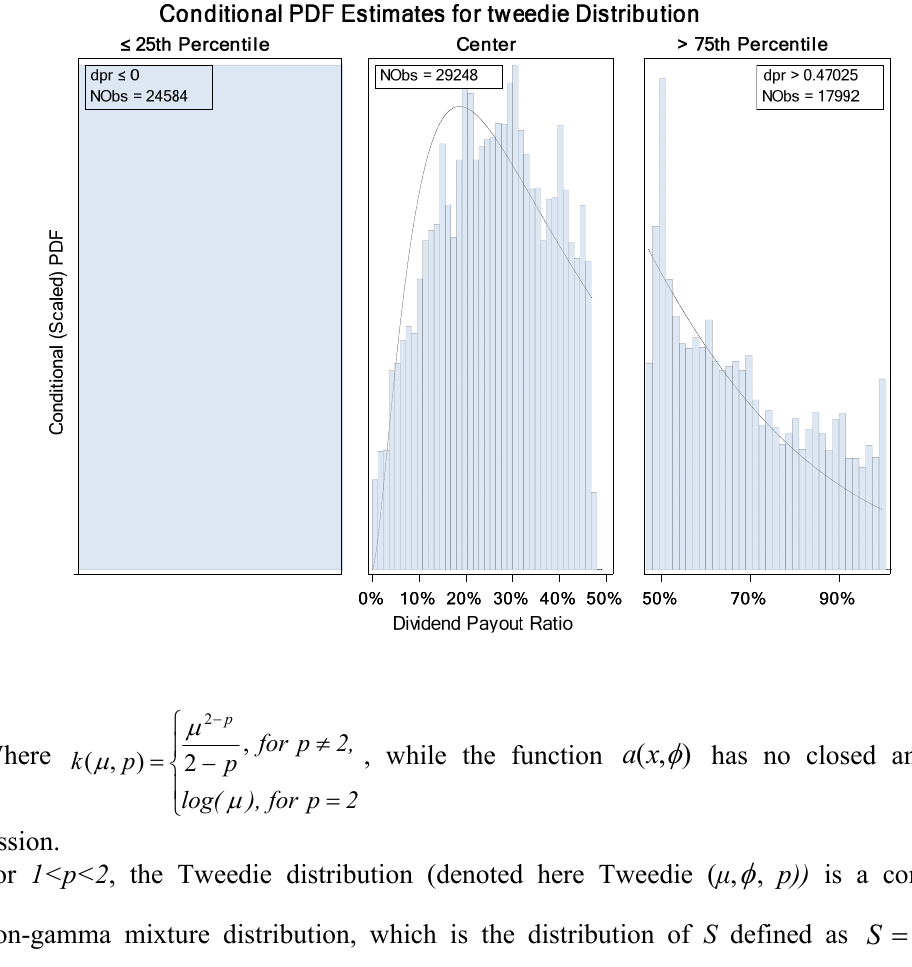
Figure 4 : The conditional probability density function estimates for Tweedie distribution against the empirical distribution: Tweedie distribution is a good choice in approximating the real